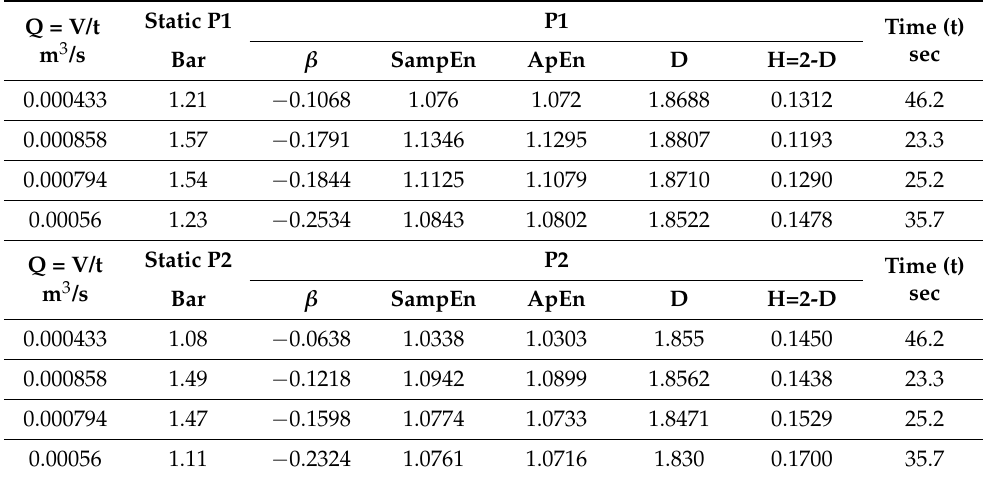
Table 1. The outcomes of the